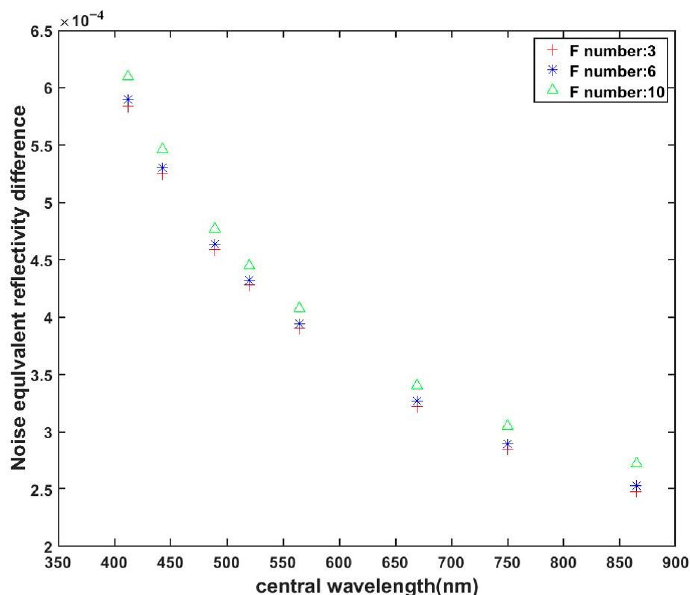
Figure 7. The noise equivalent reflectivity difference in different bands.